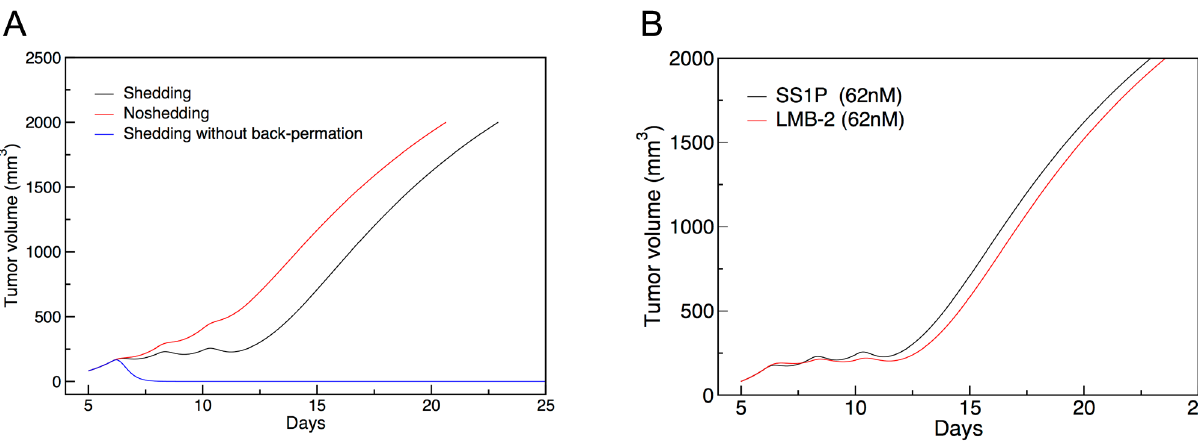
Figure 4. Computed tumor volume profiles using altered model parameters. ( A ) A431/H9 cell tumor with 3 6 62 nM injections of SS1P for three cases: No shedding (red line) and shedding with (black line; current model) and without (blue line; previous model) the back-permeation of shed antigen-immunotoxin complex to the blood vessel. ( B ) Comparison of the A431/H9 cell tumor with SS1P injection (black line) and ATAC-4 cell tumor with LMB-2 injection (red line) using the same dose (62 nM), initial volume (110 mm 3 ), and tumor growth rate ( C 0 =0.0301 hr 2 1 , a =0.00127 mm 2 3 ).